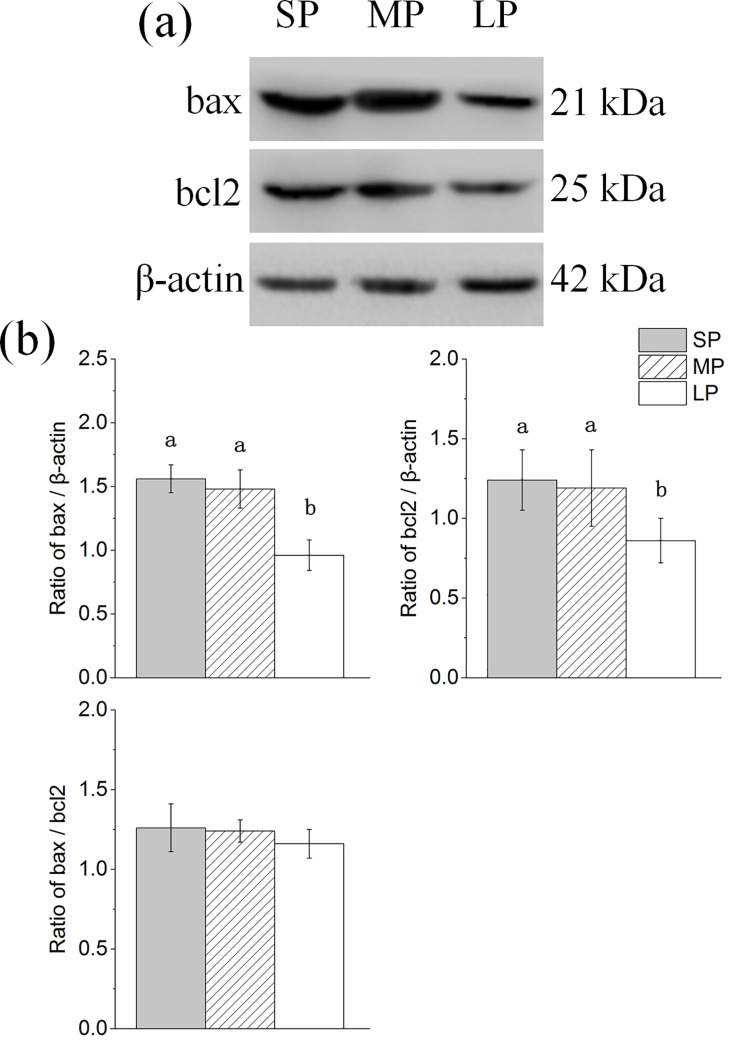
Changes in protein levels of apoptosis related factors in HG of hamsters in three different photoperiodic groups.(a) Representative immunoblots of bax, bcl2, and β-actin in three different photoperiodic groups. (b) Ratio of bax and bcl2 to β-actin and ratio of bax to bcl2 in HG of hamsters in three different photoperiodic groups. Values are means ± SD. n = 10. SP, short photoperiod; MP, moderate photoperiod; LP, long photoperiod. Different letters identify statistically significant difference (P < 0.05).